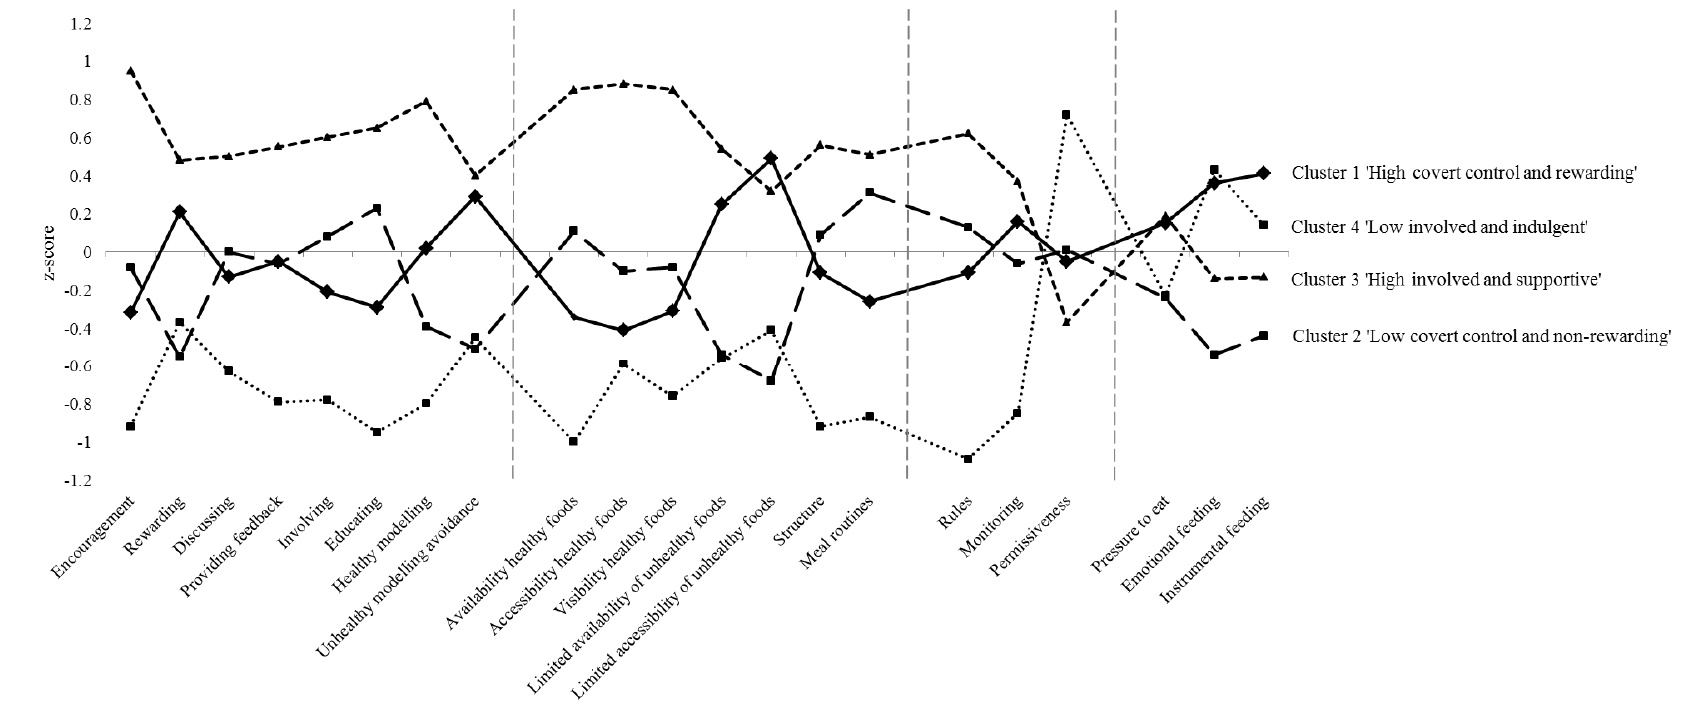
Figure 1. Graphical view of the four-cluster solution based on mean z-scores for all food parenting practices ( n = 888); Higher scores indicate more frequent use of the FPP; Each of the successive graphical areas represents a distinct category of food parenting practices, i.e. , responsiveness, structure, behavioral control and psychological control; Cluster 1 “high covert control and rewarding”: solid line; Cluster 2 “low covert control and non-rewarding”: long dashed line; Cluster 3 “high involvement and supportive”: short dashed line; Cluster 4 “low involvement and indulgent”: dotted